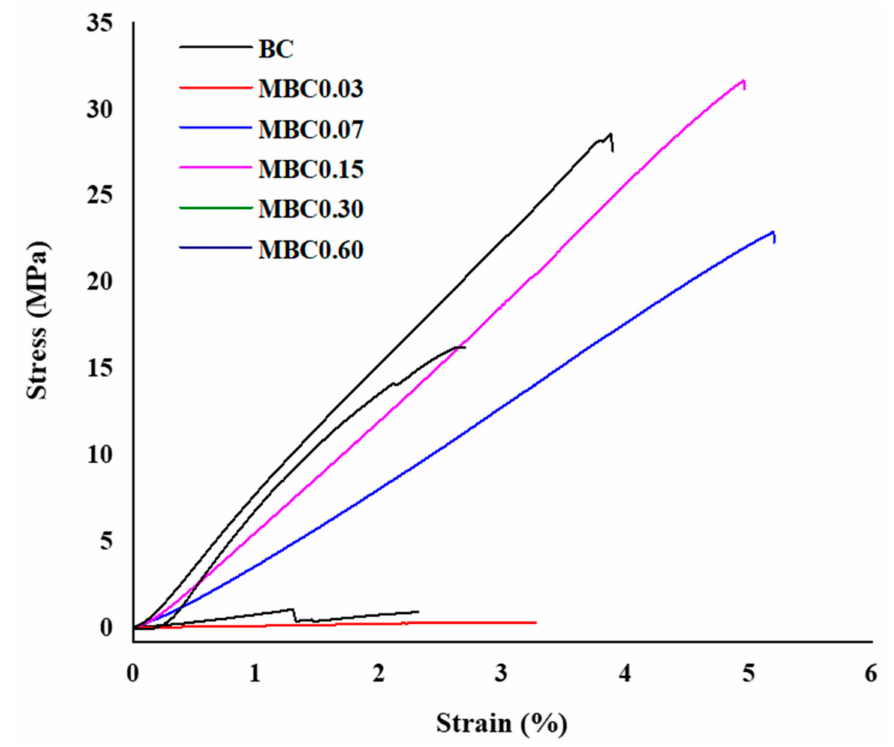
Figure 8. Mechanical properties of the modified and unmodified